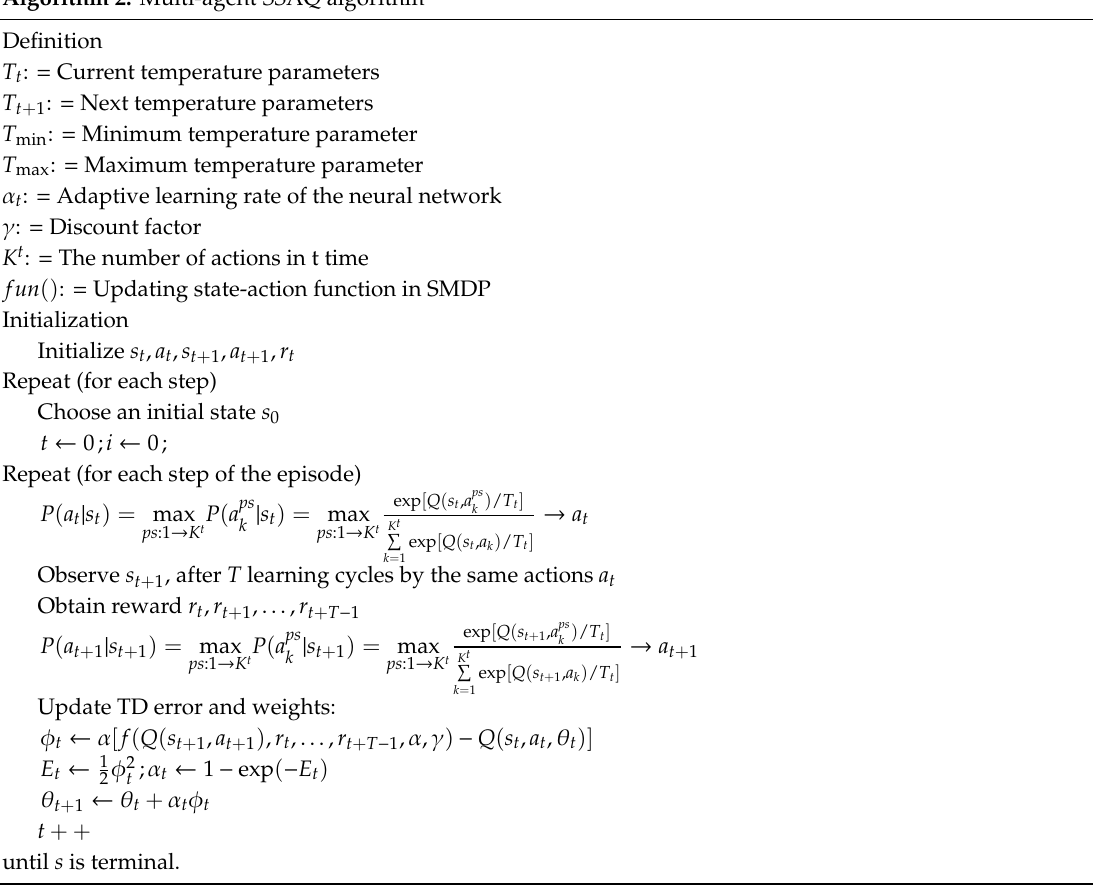
Algorithm 2: Multi-agent SSAQ